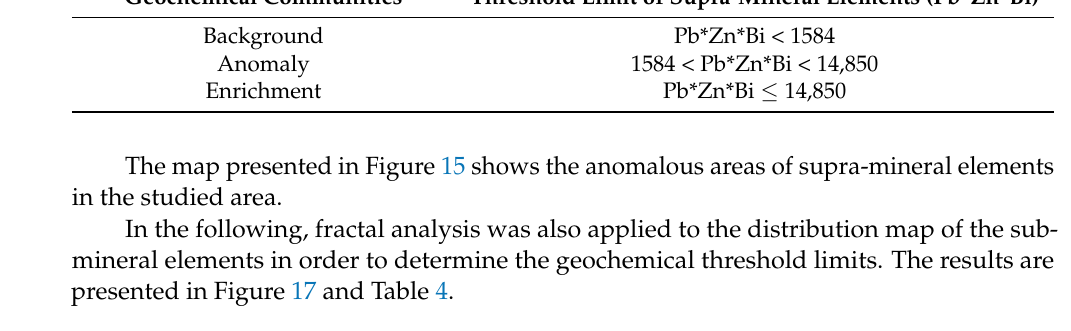
Table 3. Geochemical communities of Supra-mineral elements (Pb*Zn*Bi) based on C-A multifractal analysis.